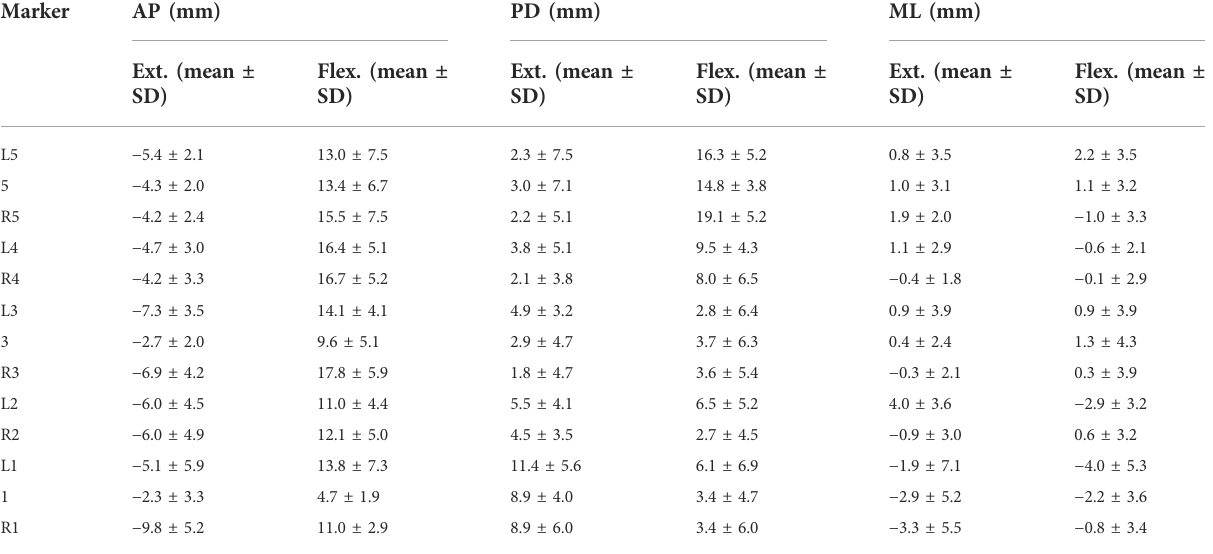
TABLE 2 Direction-related (AP, PD, and ML) mean marker artifact (mean) with their standard deviations (SDs) of all the lumbar skin markers in the fl exed and extended positions. Marker AP (mm) PD